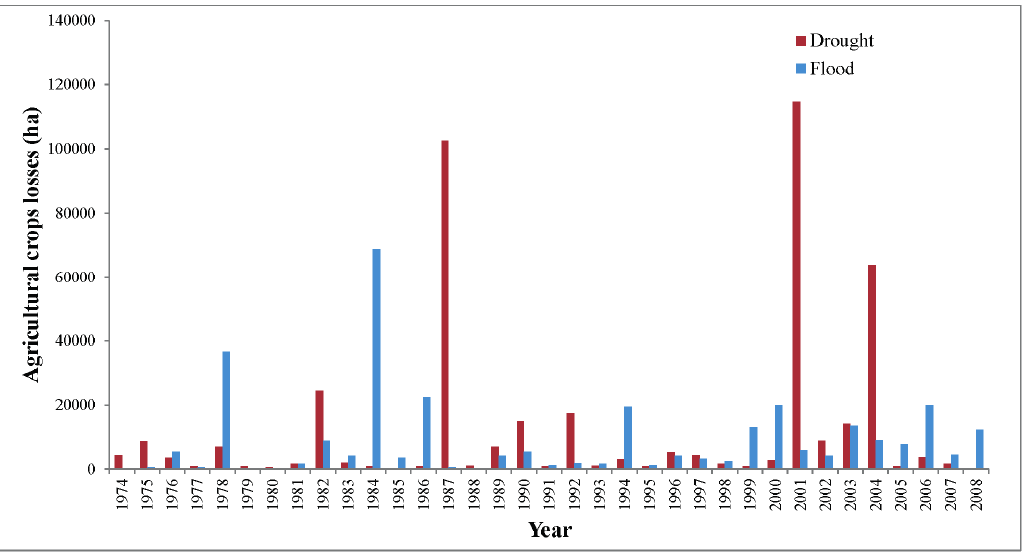
Figure 5. Losses to agricultural crops in hectares due to droughts and floods, 1974–2007. (Source: Sri Lanka National Report on Disaster Risk, Poverty, and Human Development Relationship, the Disaster Management Centre (DMC) of Sri Lanka